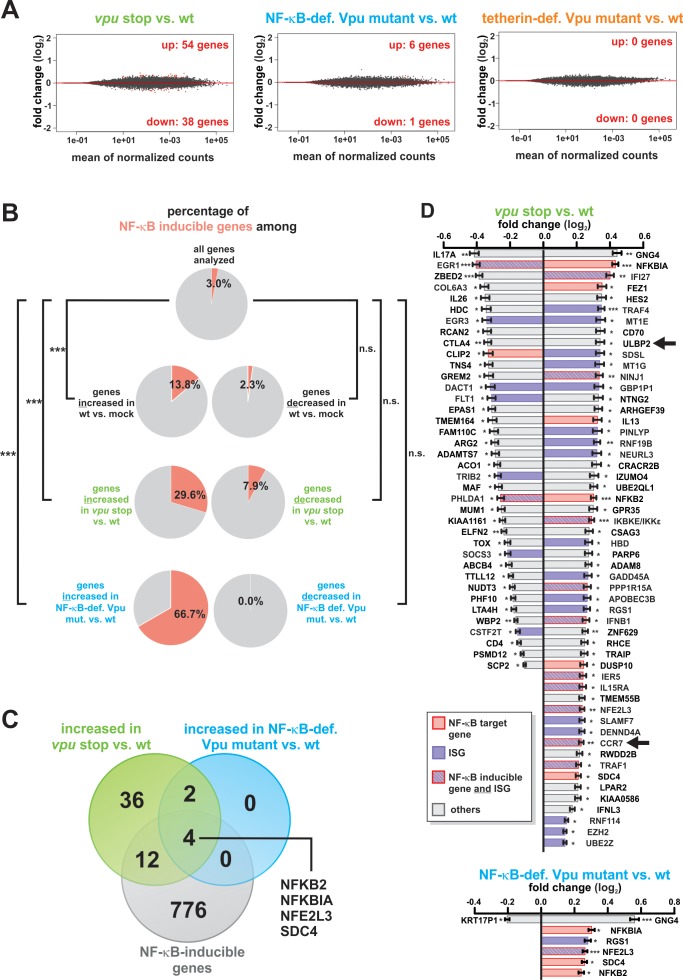
Modulation of NF-κB-dependent gene expression by Vpu.(A) MA plots illustrating the number of differentially expressed genes (red) between each vpu mutant and wt, using a P value threshold of 0.1 after Benjamini-Hochberg correction. (B) Pie charts illustrating the percentage of known NF-κB target genes among different gene sets. The analysis is based on a list of NF-κB inducible genes obtained through the NF-κB target gene database (70) (***p<0.001; n.s. not significant; Fisher’s exact test). (C) Venn diagram illustrating the overlap of NF-κB inducible genes (70) and genes, whose expression is suppressed by Vpu. (D) Genes that are differentially expressed in vpu stop vs. wt (top panel) or NF-κB-def. Vpu mutant vs. wt (bottom panel) infected CD4 +T cells. NF-κB inducible genes (70) and ISGs (Rusinova et al., 2013) are highlighted in pink and purple, respectively. Statistical significance was determined using negative binomial generalized linear models as implemented in DESeq2 (* q < 0.1; ** q < 0.01; *** q < 0.001) (Love et al., 2014). Arrows highlight previously identified targets of Vpu.